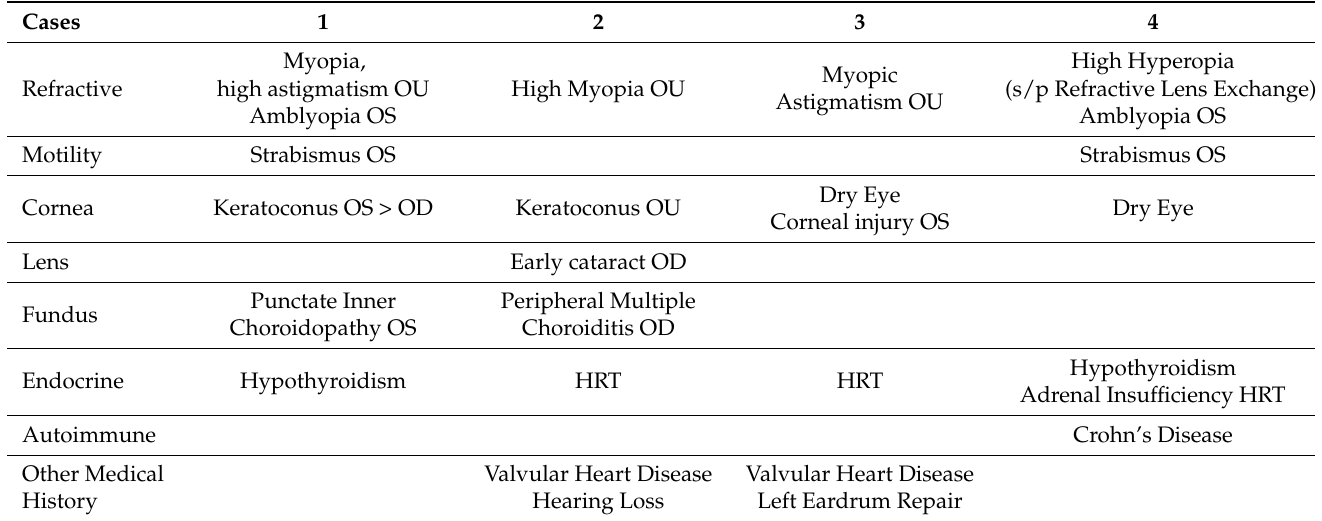
Table 2. Summary of Turner Syndrome